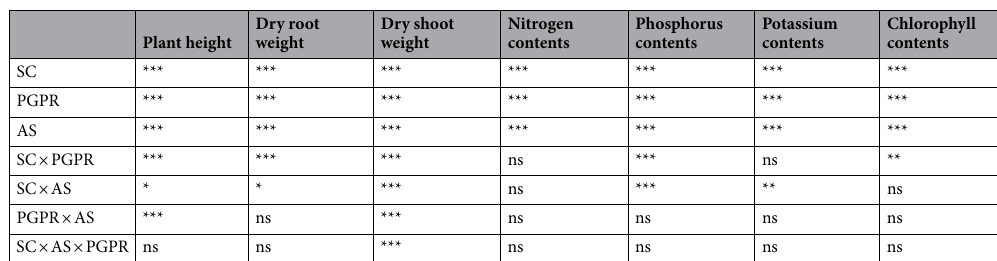
Table 1. Three-way ANOVA results represented as level of significance of the effect of factors soil substrate composition (SC), Alternaria solani (AS) and plant growth promoting rhizobacteria; Bacillus subtilis (BS) and their interactions on tomato plant growth and physiological parameters. ns non-significant. * P ≤ 0.05; ** P < 0.01 *** P < 0.001.